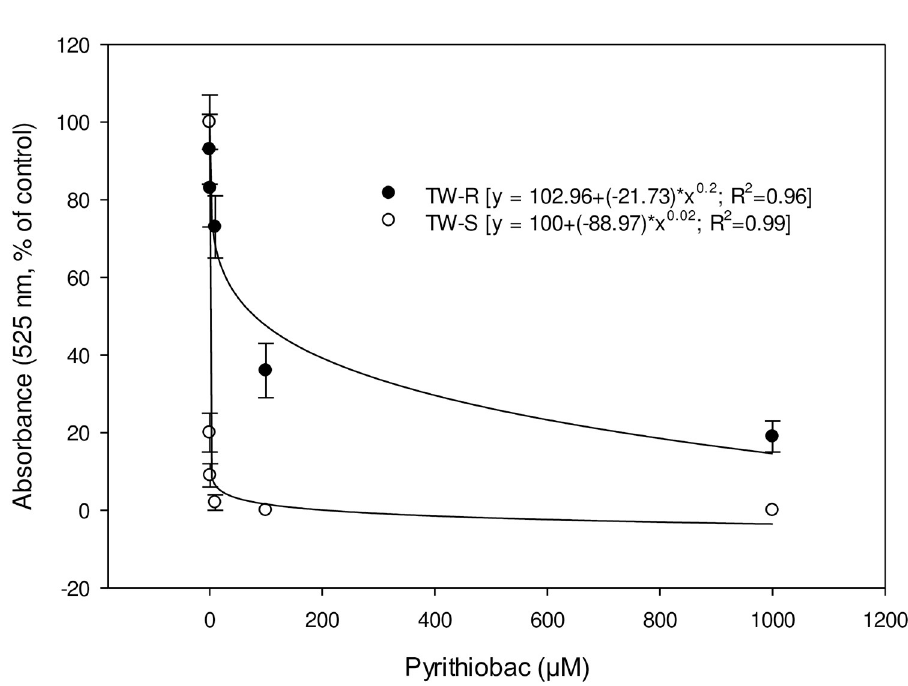
Fig 8. Pyrithiobac dose response on ALS enzyme activity of ALS-inhibiting herbicide-resistant (TW-R) and -susceptible (TW-S) Amaranthus tuberculatus populations from Mississippi. Vertical bars represent standard error of